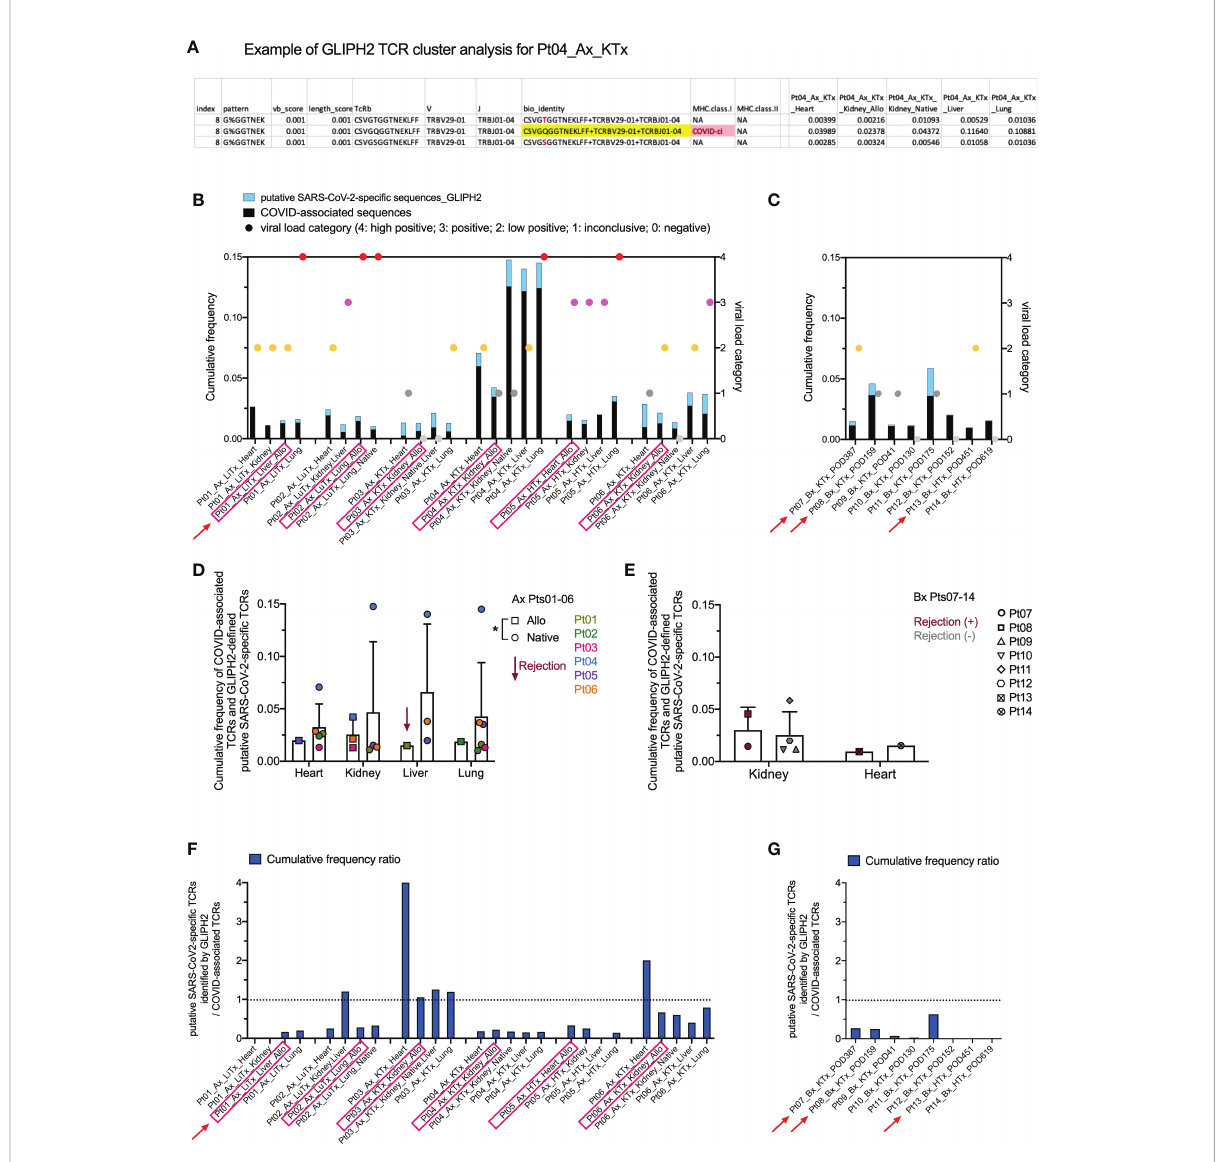
FIGURE 6 Identi fi cation of putative SARS-CoV-2-speci fi c TCRs and their clonal distribution across individual patients and tissue types. (A) A representative example of de fi ning putative SARS-CoV-2-speci fi c TCRs in Pt04 by applying the GLIPH2 clustering algorithm in reference to the immuneCODE ™ MIRA database is shown in the table. Three TCRs, each with a unique CDR3 + v + j sequence at the amino acid level (bio_identity), formed a cluster (Index 8) by sharing the same structural pattern of “ G%GGTNEK ” . One TCR highlighted in yellow in the bio_identity column overlaps with the sequence validated as SARS-CoV-2-speci fi c TCR with MHC class I restriction in the MIRA database. The other two TCRs in this cluster, which are termed as “ putative SARS-CoV-2-speci fi c TCRs ” , differ with one amino acid highlighted in red compared to the reference TCR. Cumulative frequencies of each TCR in different autopsy specimens of Pt04 are shown in the last fi ve columns of the table. (B, C) Left Y axis: combined cumulative frequency of COVID-associated TCRs (black bars) and GLIPH2-de fi ned putative SARS-CoV- 2-speci fi c TCRs (light blue bars). Right Y axis: viral load categories. Autopsy and biopsy specimens are shown in B and C, respectively, with allograft samples highlighted with pink rectangles and red arrows indicate graft rejection determined by histology. (D) Cumulative frequency of COVID-associated TCRs and GLIPH2-de fi ned putative SARS-CoV-2-speci fi c TCRs in different organs subgrouped by allografts (squares) and native tissues (circles) for autopsy specimens of Pts01-06. (E) Cumulative frequency of COVID-associated TCRs and GLIPH2-de fi ned putative SARS-CoV-2-speci fi c TCRs in kidney or heart biopsies of Pts07-14 subgrouped by rejection status. No statistical signi fi cance was determined by Two-way ANOVA, followed by Tukey ’ s multiple comparisons test for panel D-E. Cumulative frequency ratios of GLIPH2-de fi ned putative SARS- CoV-2-speci fi c TCRs vs COVID-associated TCRs in autopsy (F) and biopsy (G) specimens are